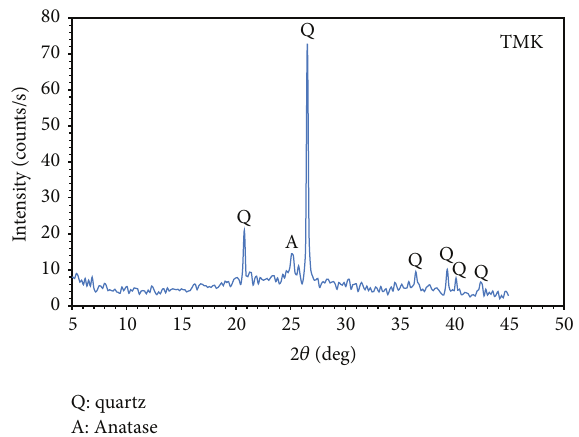
Figure 2: XRD pattern of the calcined Ti-containing Kaolin (Ti-metakaolinite) after calcination to metakaolinite (TMK) at 700 ∘ C/4h.